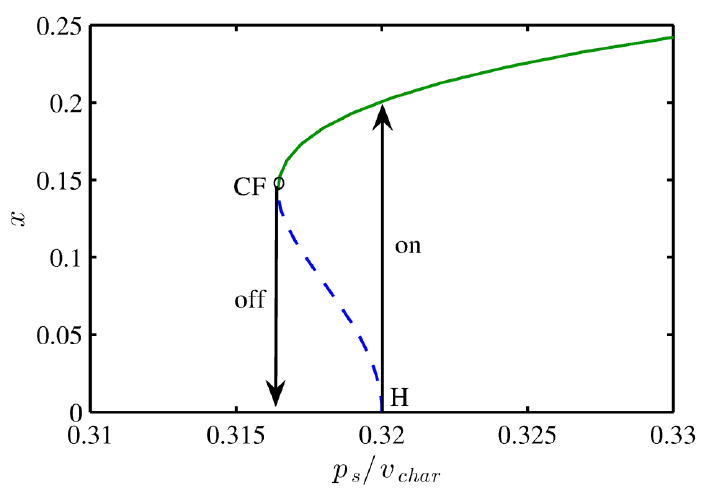
Figure 2. Bifurcation diagram for h ( x ) = r + sx 4 , with r = 0.32, s = 64. The “on” arrow shows the oscillation onset at a subcritical Hopf bifurcation (H), whereas the “off” arrow shows the oscillation offset at a cyclic fold bifurcation [17].